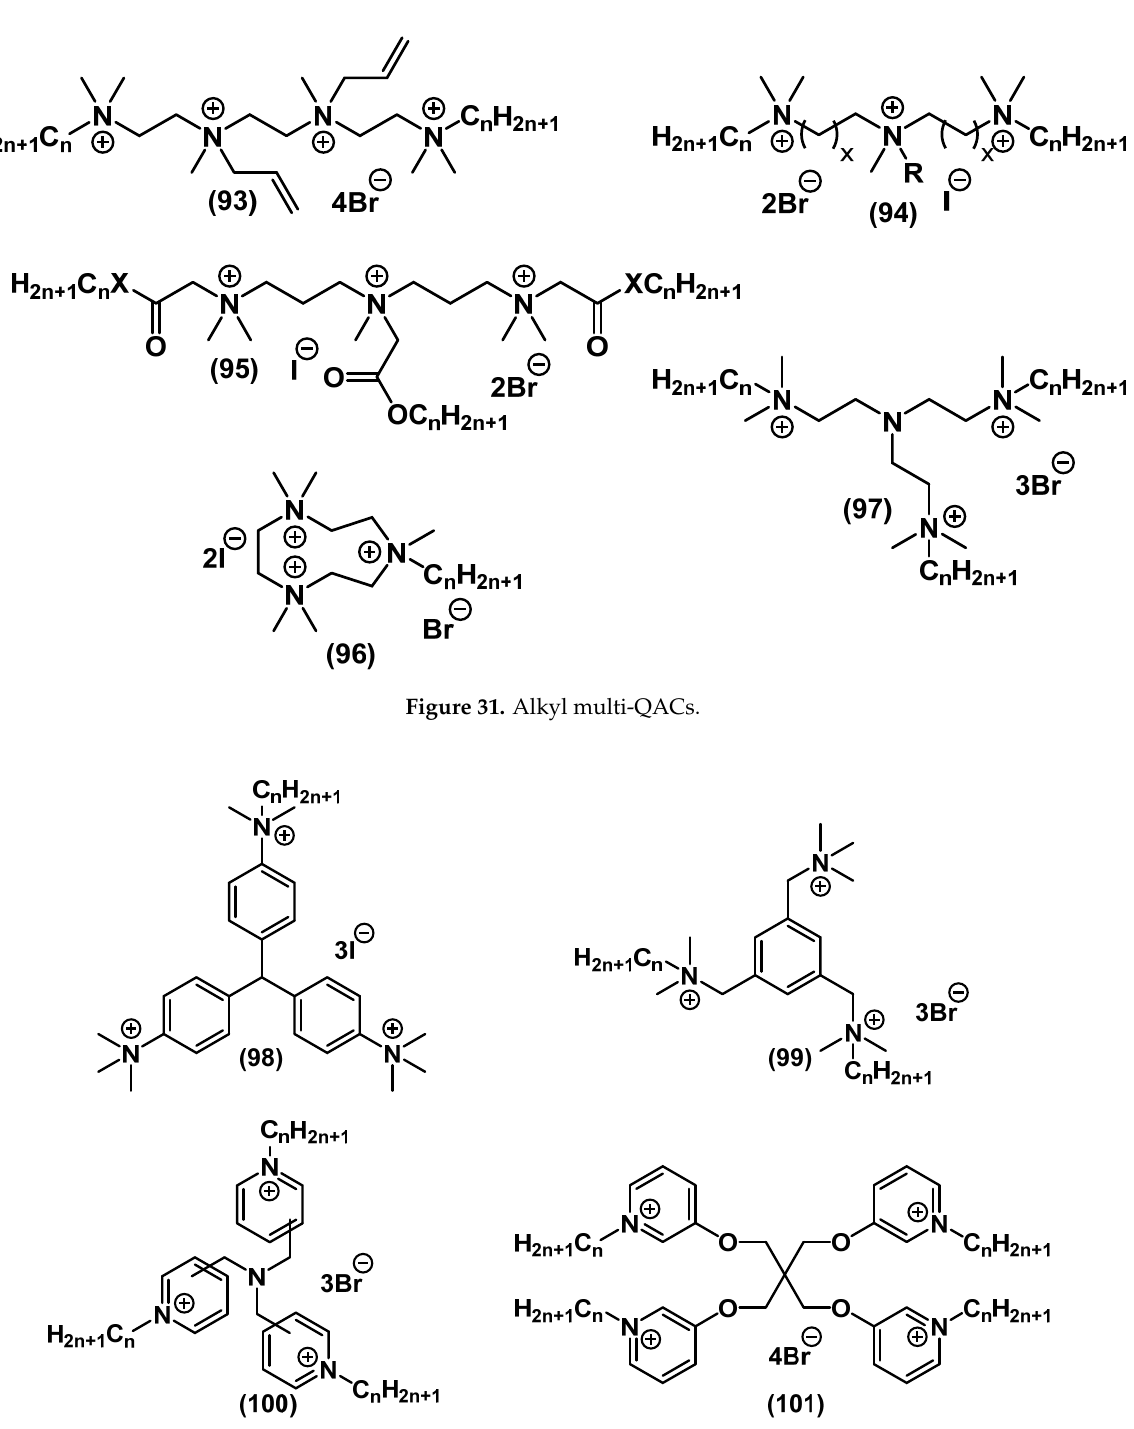
Figure 32. Multi-QACs with aromatic fragments.